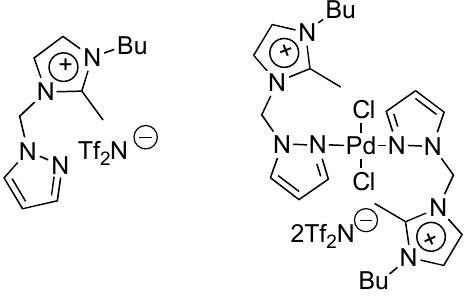
Figure 1. Palladium complex from N-pyrazolyl 2-methyl imidazolium based